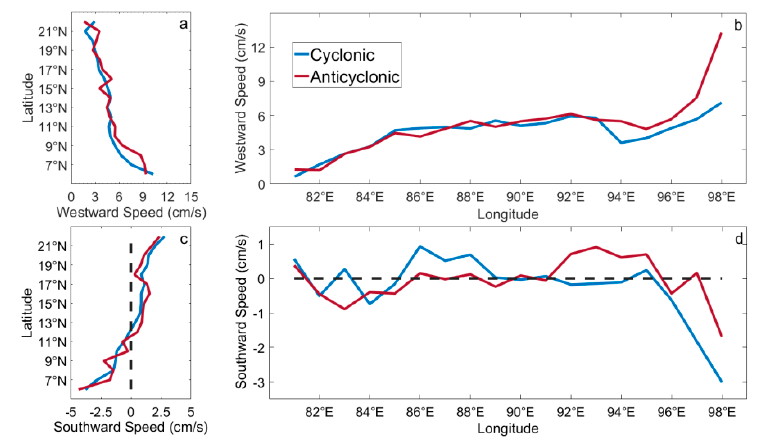
Figure 14. Zonal and meridional average propagation speeds of eddies. Westward speed variation with ( a ) latitude and ( b ) longitude. Southward speed variation with ( c ) latitude and ( d ) longitude. The positive values indicate the westward and southward speeds (unit: cm / s). (The dotted line indicates that the speed is 0 cm / s).